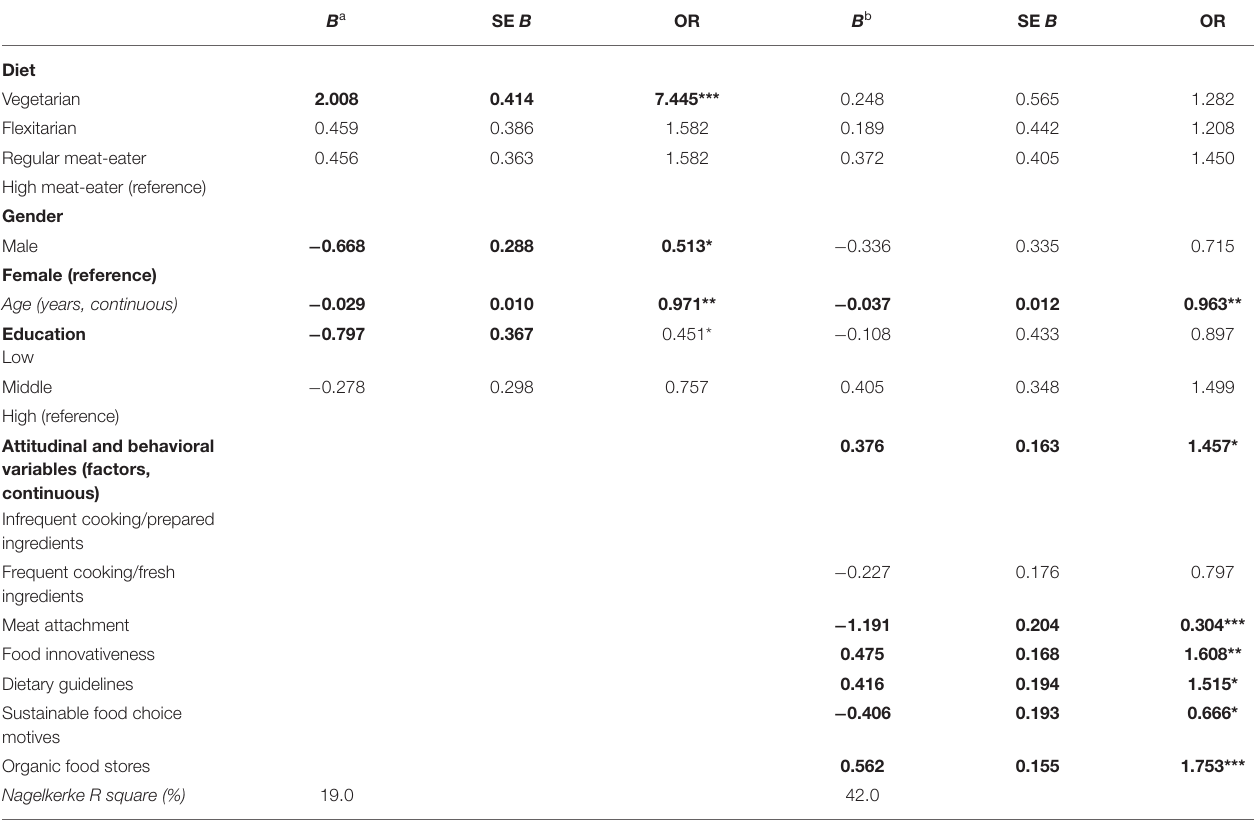
TABLE 6 | Results of a binary logistic regression analysis predicting consumption of plant-based meat alternatives ( N =